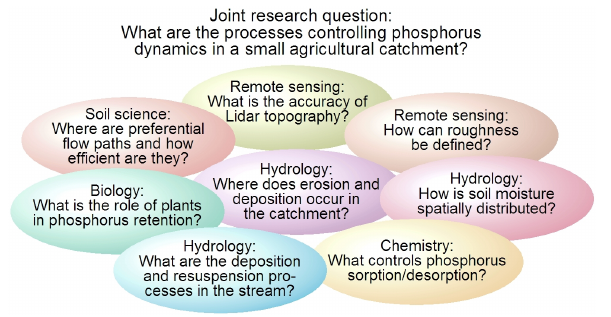
Fig. 4. Example of an overarching joint research question show- ing the interplay between the disciplines in addressing the question. The individual questions contributing to the joint research question are typically addressed in one research paper.